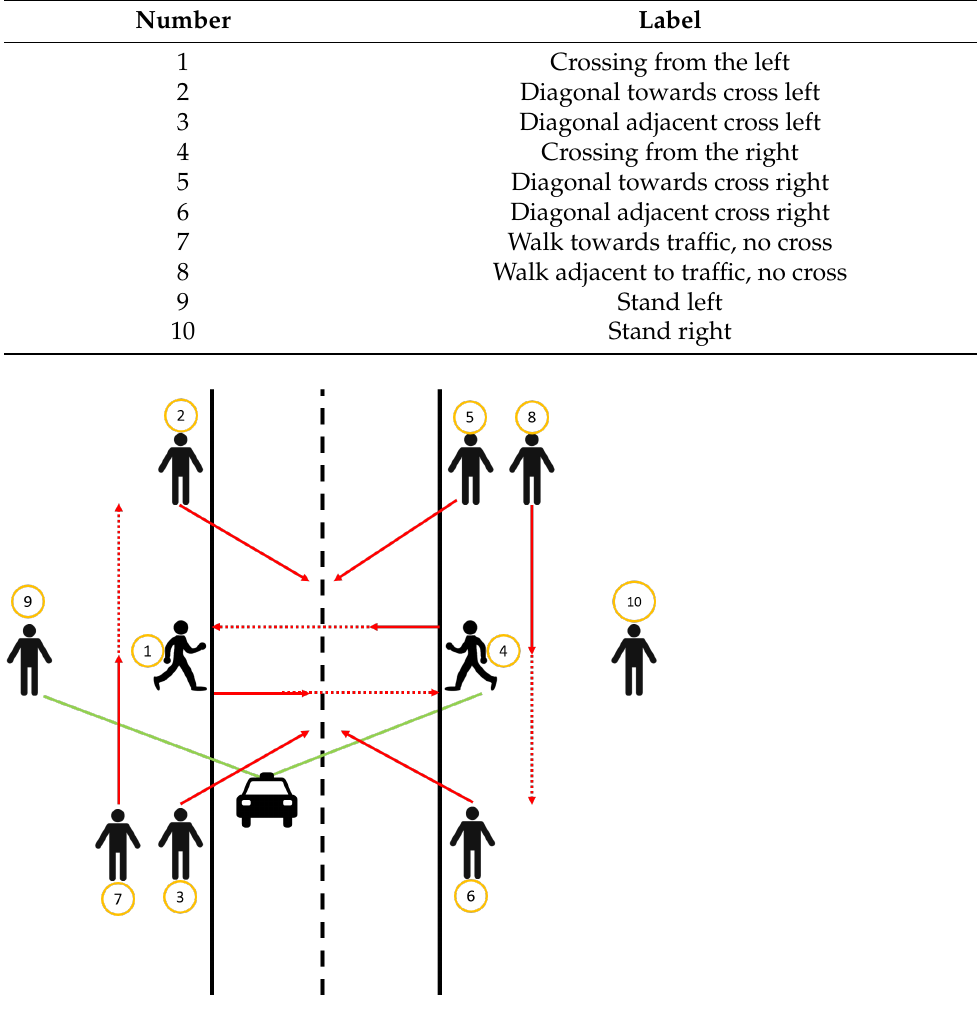
Figure 1. Pedestrian movement classes. Table 4. Secondary behavior